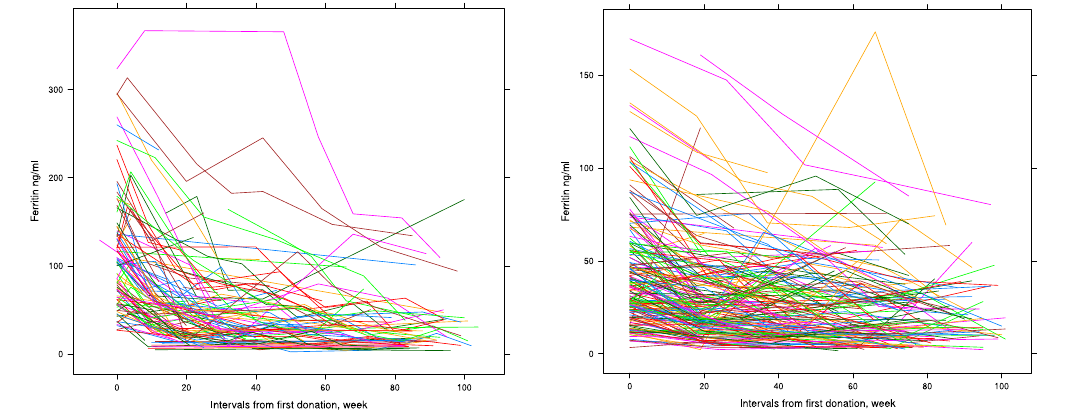
Figure 1. Spaghetti plots demonstrating ferritin levels over repeated donations per individual male ( left ) and female donor ( right ) in the FIND+ study by time since baseline, September 2017 – September 2019.